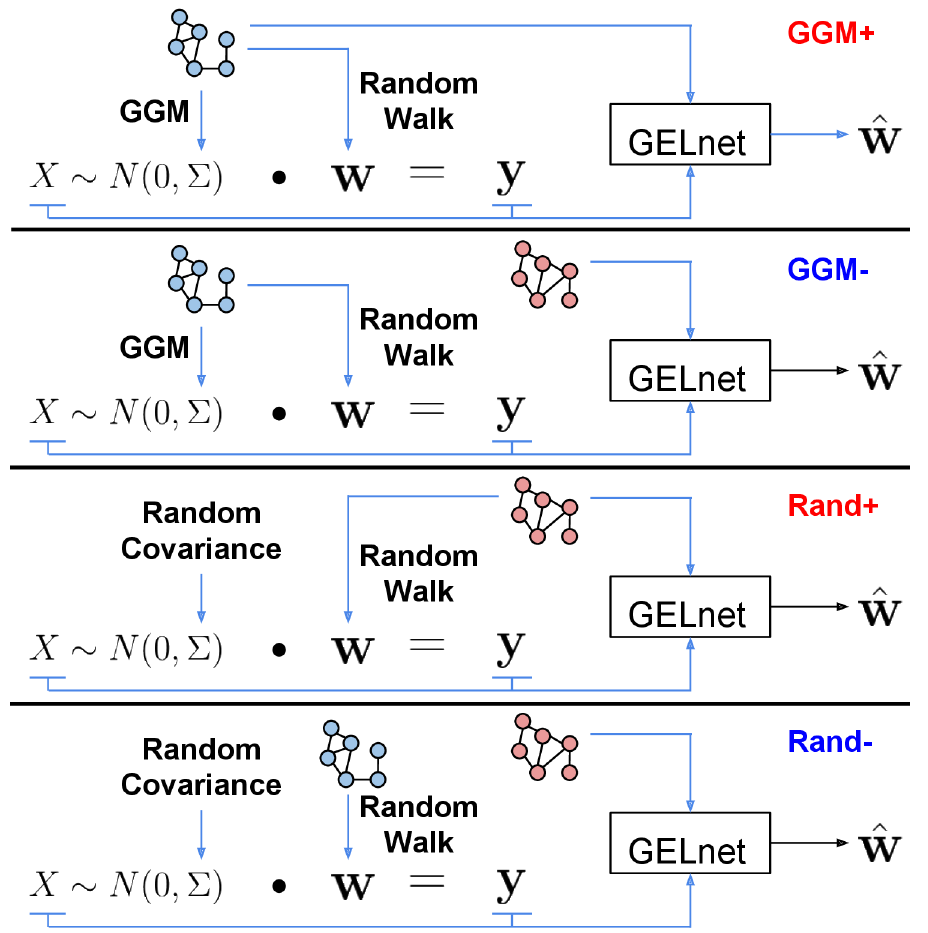
Fig 1. Overview of four synthetic data scenarios. In GGM+ and GGM-, the same network is used to simulate the gene expression matrix X and the signaling pathway represented by the weight vector w . That network is then provided to the GELnet in the GGM+ scenario, while a permuted version is used in the GGM- scenario. Scenarios Rand+ and Rand- are constructed in a similar fashion, but using a random covariance matrix